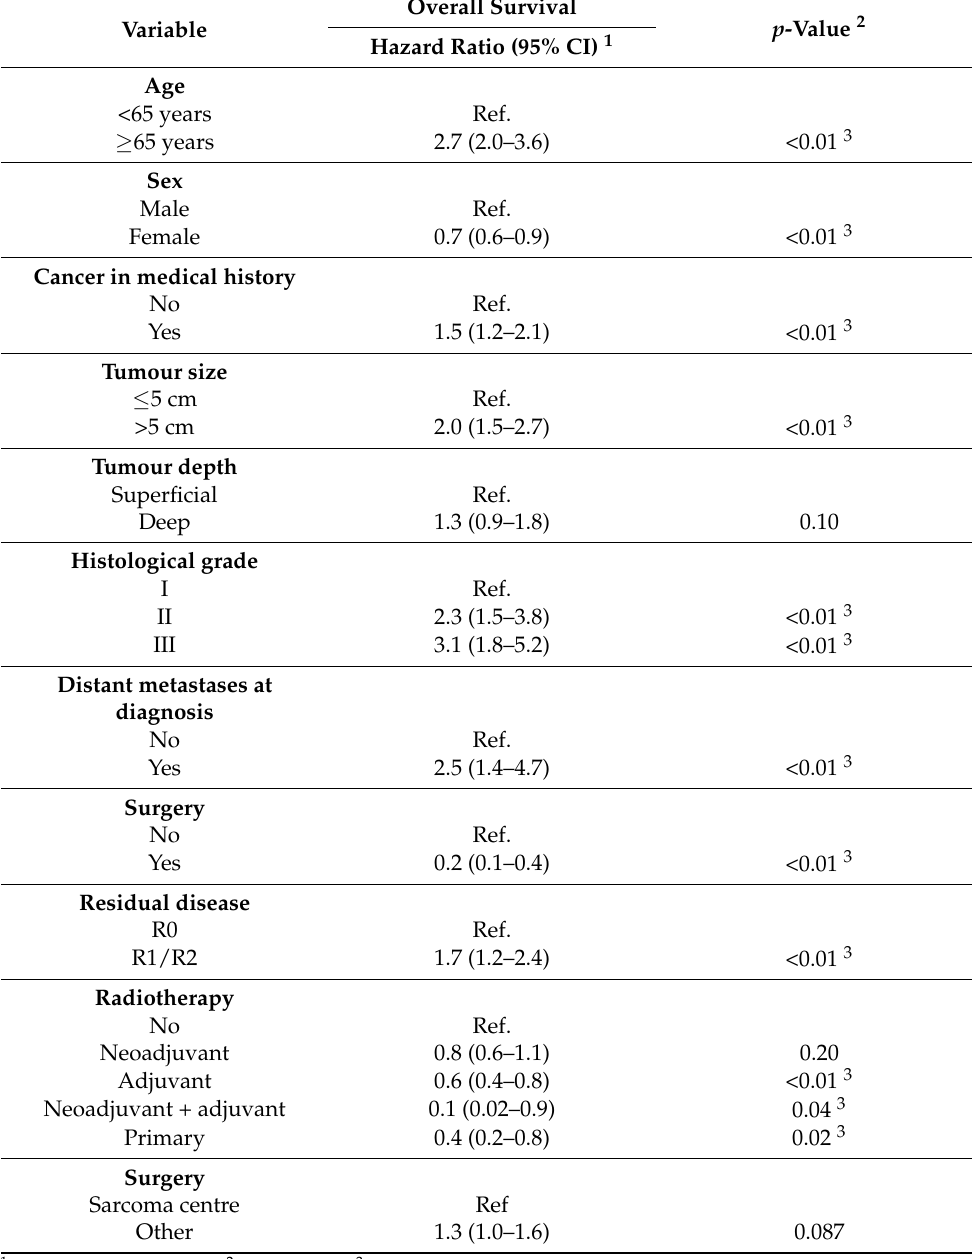
Table 1. Multivariable survival analysis with imputed